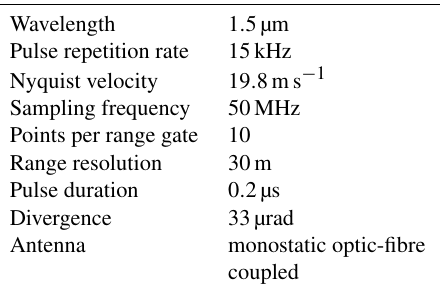
Table 2. Halo Photonics Streamline and Streamline XR heterodyne Doppler lidar